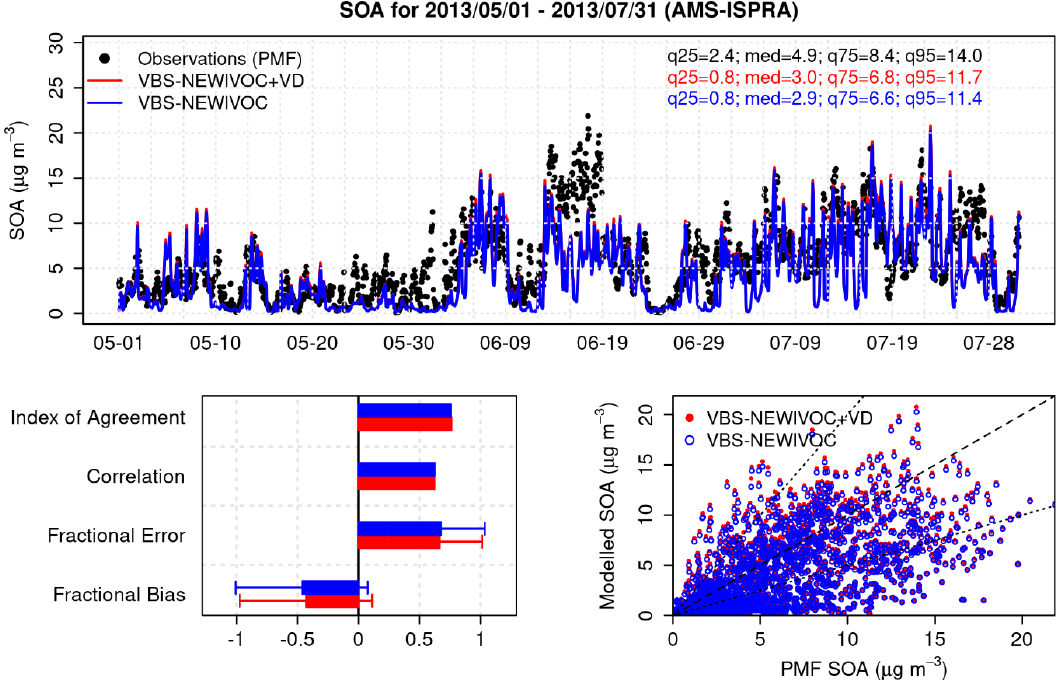
Figure 5. Comparison among modeled and observed (PMF results, black) SOA concentrations during May–July 2013 at the Ispra site: VBS scheme with new parameterizations for IVOC emissions (VBS-NEWIVOC, blue) and VBS scheme with new parameterizations for IVOC emissions and revised volatility distribution (VBS-NEWIVOC+VD, red).